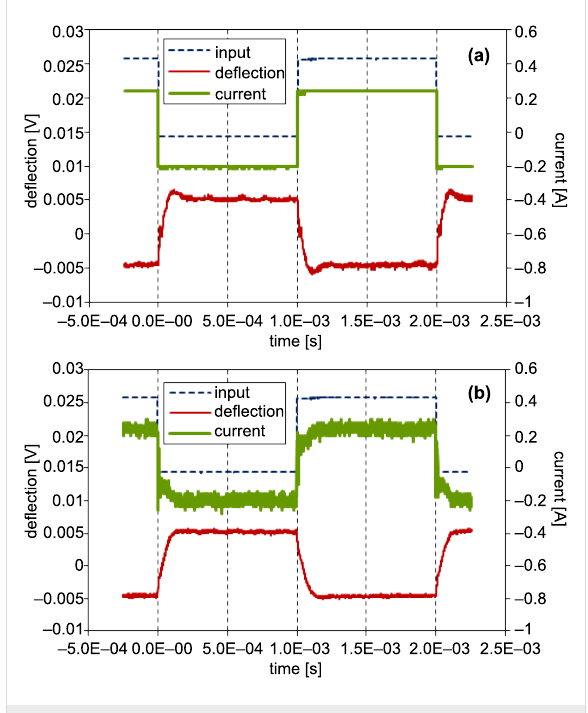
Figure 3: Effect of Q-control on the step-response of the cantilever recorded at about 700 nm from a mica substrate in water with zero Q-control gain (a) and with the optimum gain (b). The fine broken, thick solid, and fine solid lines indicate the input-voltage signal, current in the electromagnet, and cantilever deflection, respectively. The cantilever swing amplitude corresponds to about 4